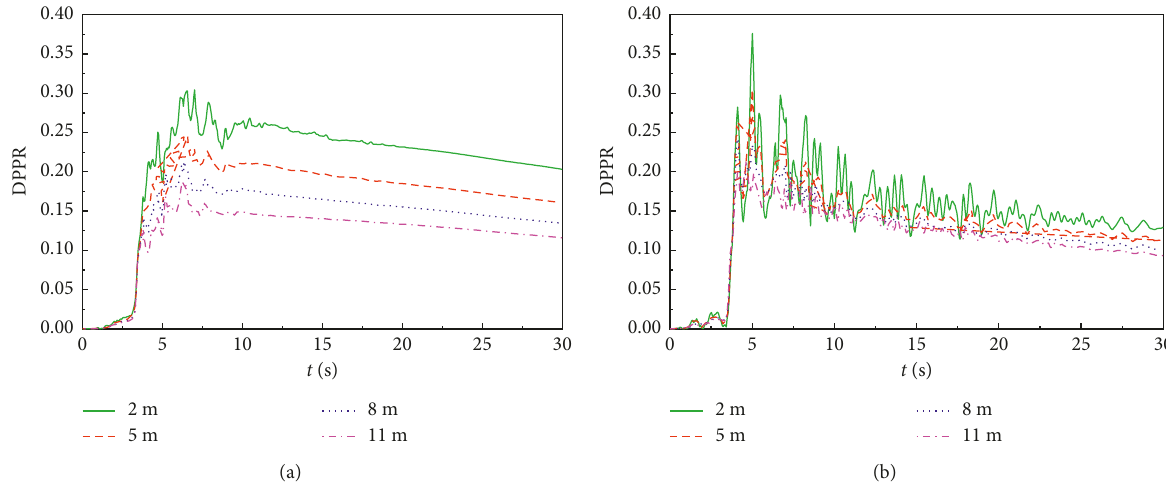
Figure 11: Time-history curves of the dynamic pore pressure ratio of typical points with different burial depths in soft soil ground: (a) F (b) F 2